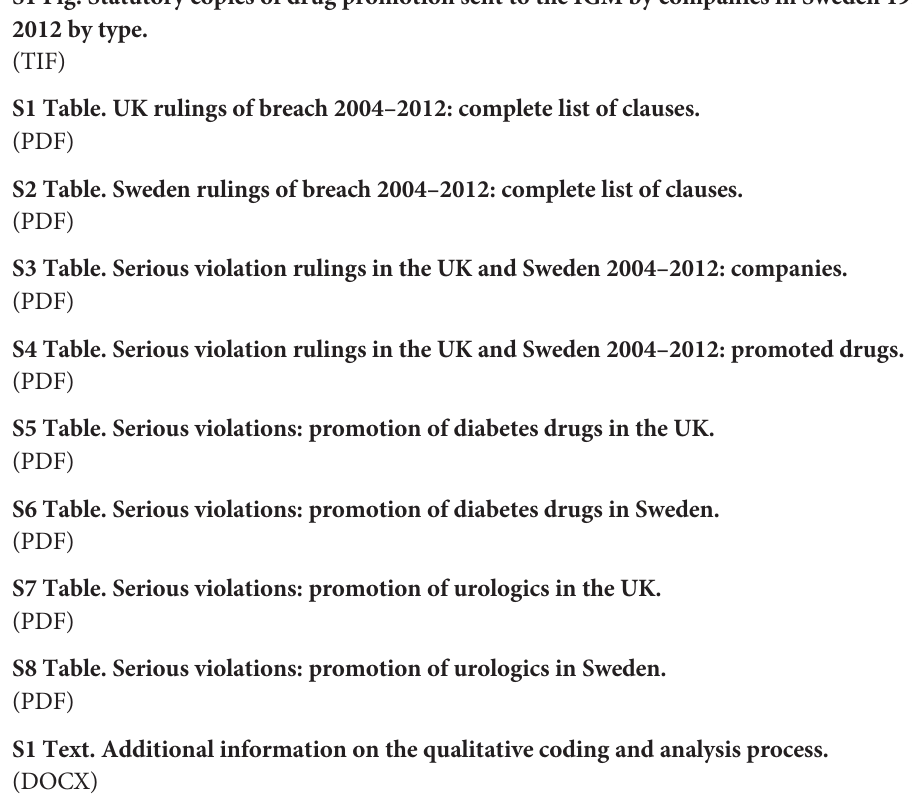
S5 Table. Serious violations: promotion of diabetes drugs in the UK. S6 Table. Serious violations: promotion of diabetes drugs in Sweden. S7 Table. Serious violations: promotion of urologics in the UK. S8 Table. Serious violations: promotion of urologics in